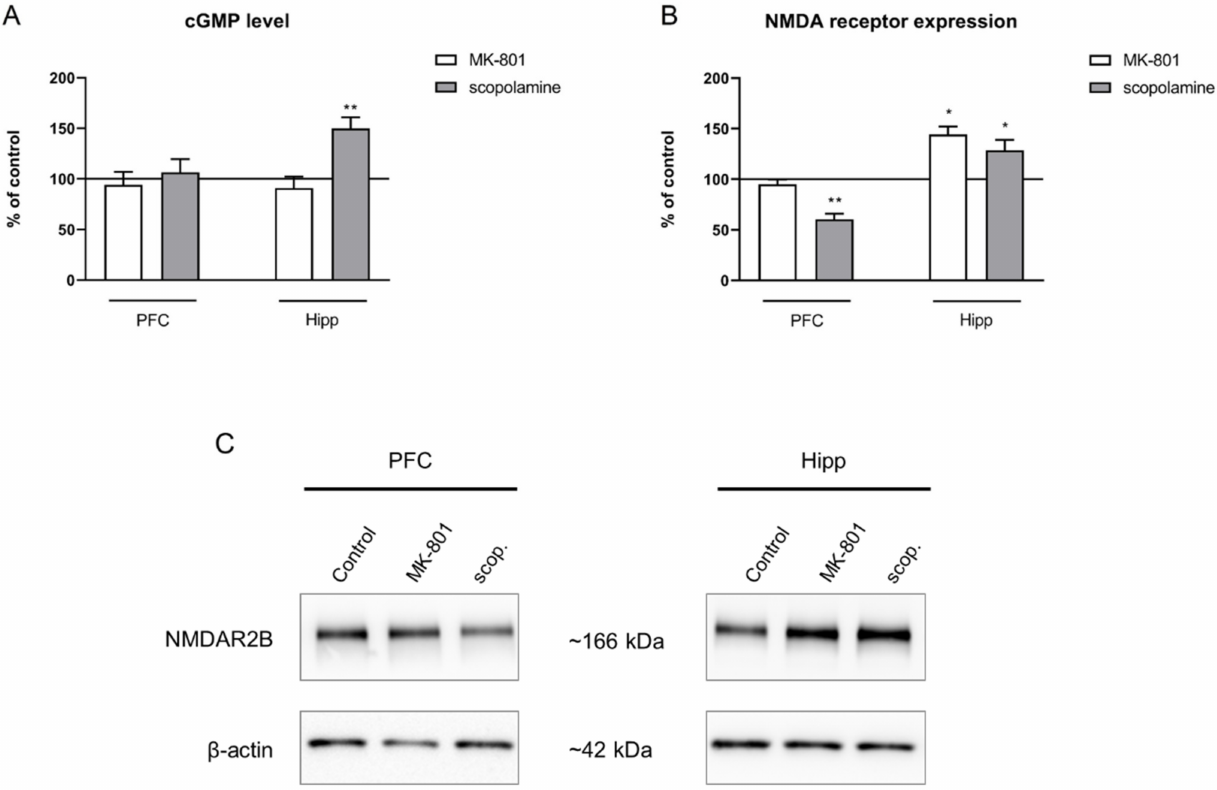
Figure 14. cGMP level ( A ) and GluN2B subunit-containing NMDA receptor expression ( B ) in the prefrontal cortex (PFC) and hippocampus (Hipp) after chronic (14 days) administration of MK-801 (0.3 mg/kg) or scopolamine (1 mg/kg). ( C ) Representative Western blots. Data are presented as means ± SEM. * p < 0.05; ** p < 0.01 vs.